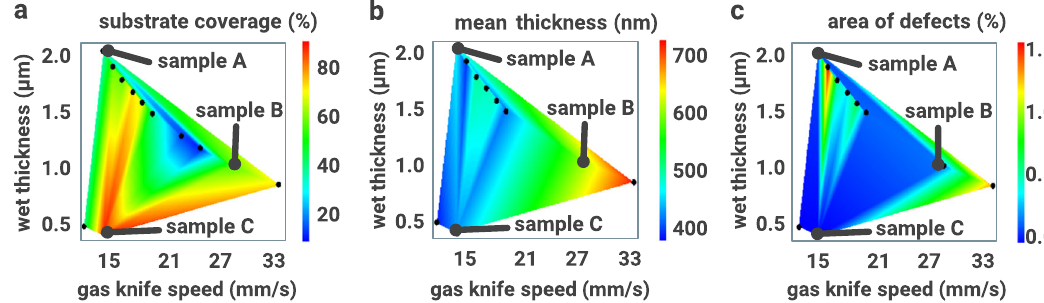
Fig. 2 Linking the slot-die coating process parameters to the perovskite fi lm morphology. a Substrate coverage ratio extracted from 12 slot-die coated perovskite fi lm images during process optimization, de fi ned as the ratio between the covered area and the total coated area. b Mean thickness of the perovskite fi lms. c Area of defects, calculated as the ratio of defect area (white pixels) to covered